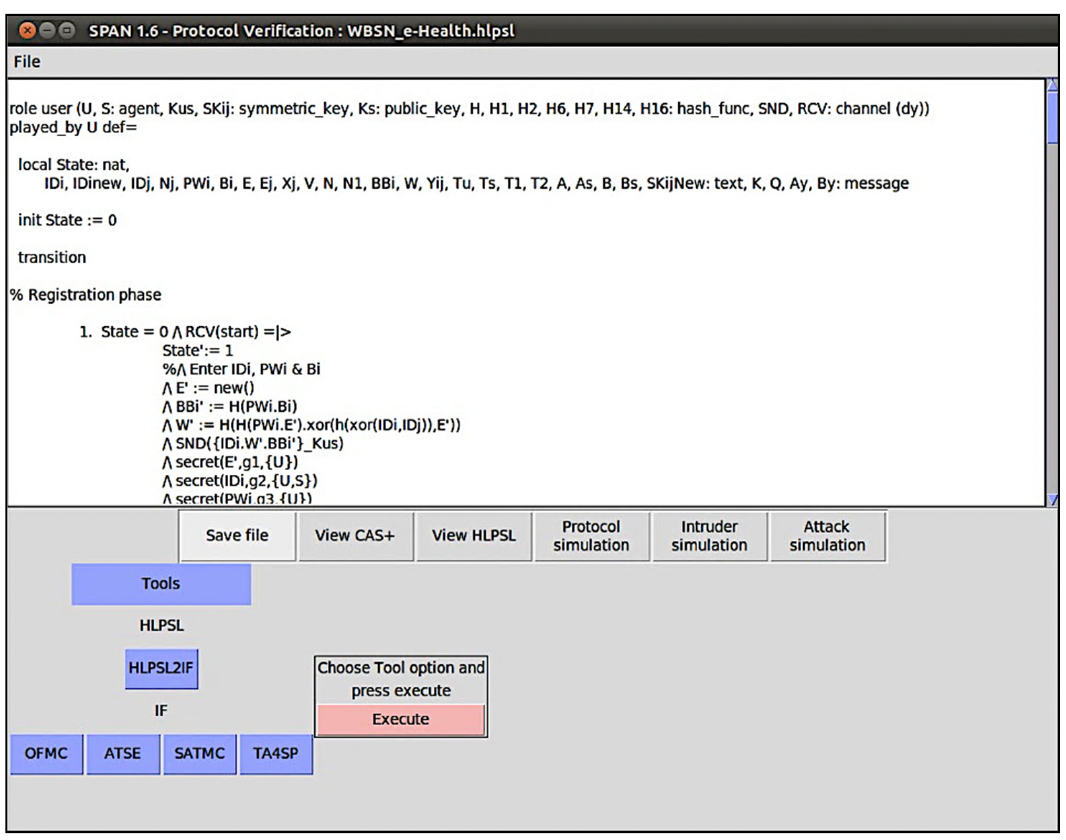
Figure 6. Security Protocol Animator for AVISPA.